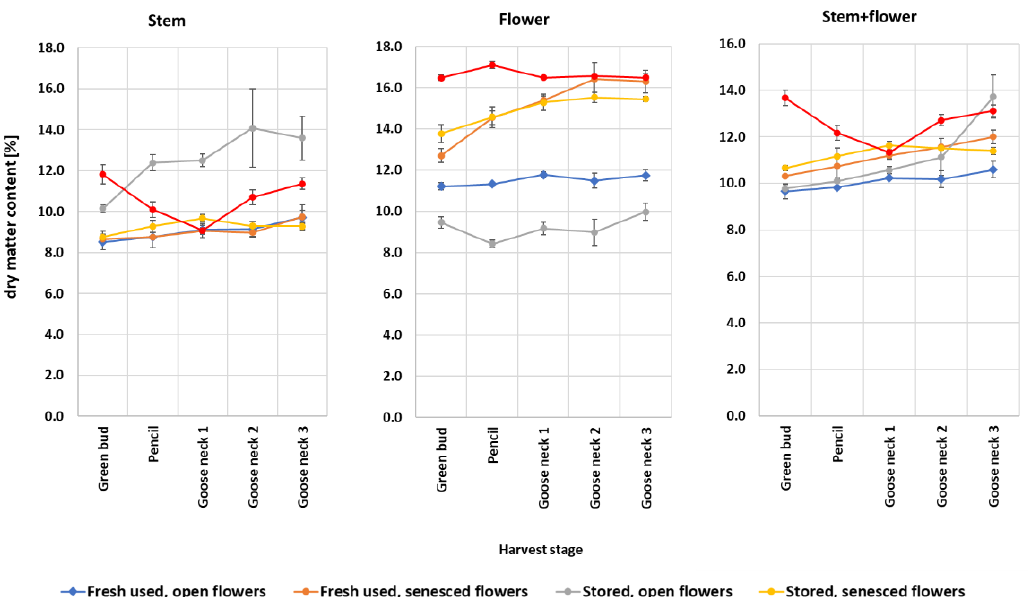
Figure 13. Dry matter content. Bud stages: green bud (GB); pencil: white bud, upright (PE); goose neck 1: white bud, skew (GN1); goose neck 2: white bud, horizontal (GN2); goose neck 3: big white bud, horizontal, maximum with 1 opening petal (GN3).